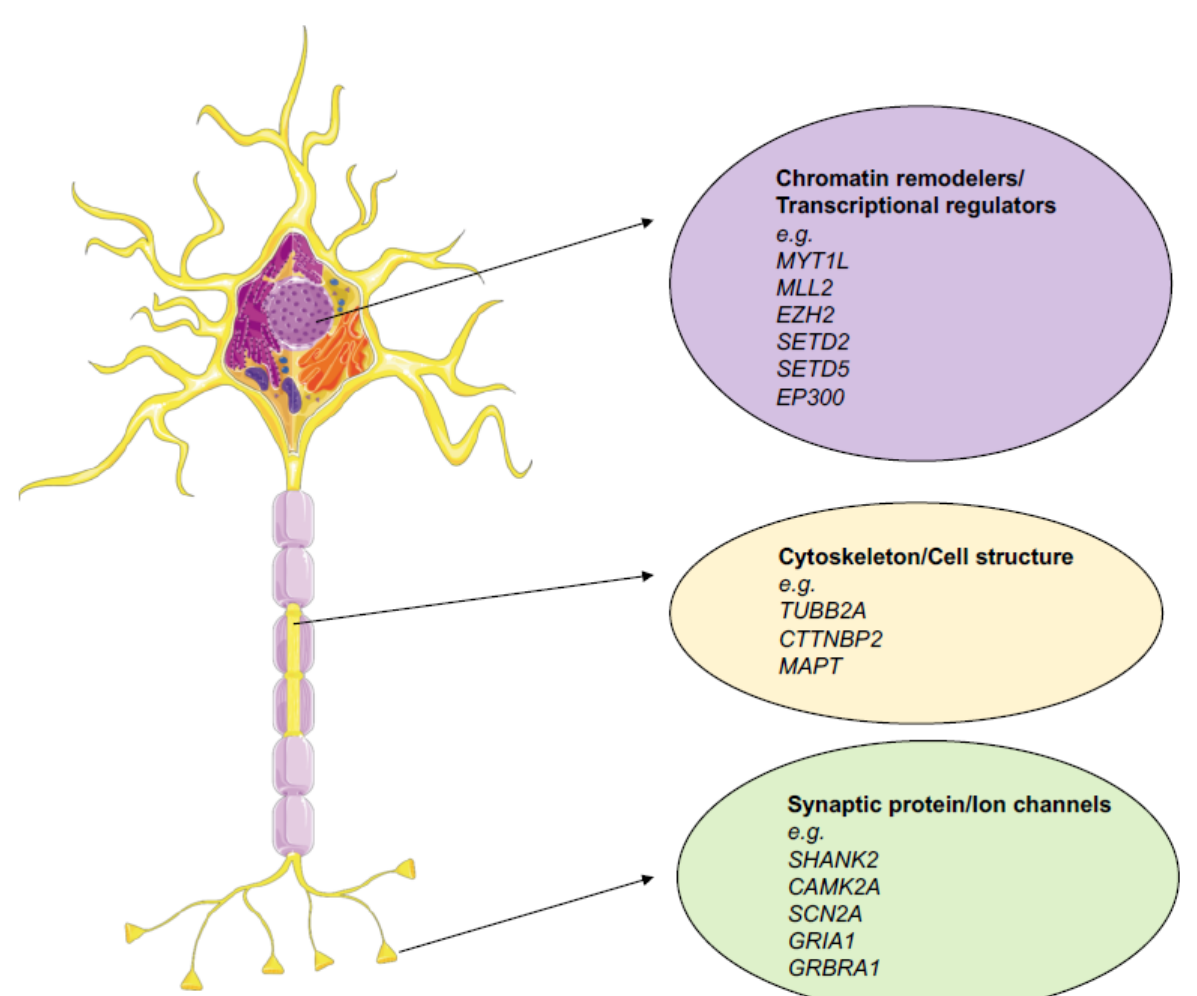
Figure 1. Main gene categories affected in NDDs with some relevant examples. Chromatin remodelers are genes that are implied to be involved in the regulation of chromatin in an activatory ( EP300, MLL2 ) or repressive manner ( EZH2, MLL2 ). Others control transcriptional processivity, such as ( SETD2 and SETD5 ). Cytoskeleton proteins such as CTTNBP2 and MAP2 are associated with the cytoskeleton and help to preserve its integrity. Others, such TUBB2A, are structural proteins that directly form its structure. Synaptic proteins and ion channels can be associated with different tasks, functionally active channels ( SCN2A ), neurotransmitter receptors ( GRIA1 and GRBRA1 ), calcium-responsive proteins ( CAMK2A ), and proteins that are associated with the synaptic structure ( SHANK2 ).